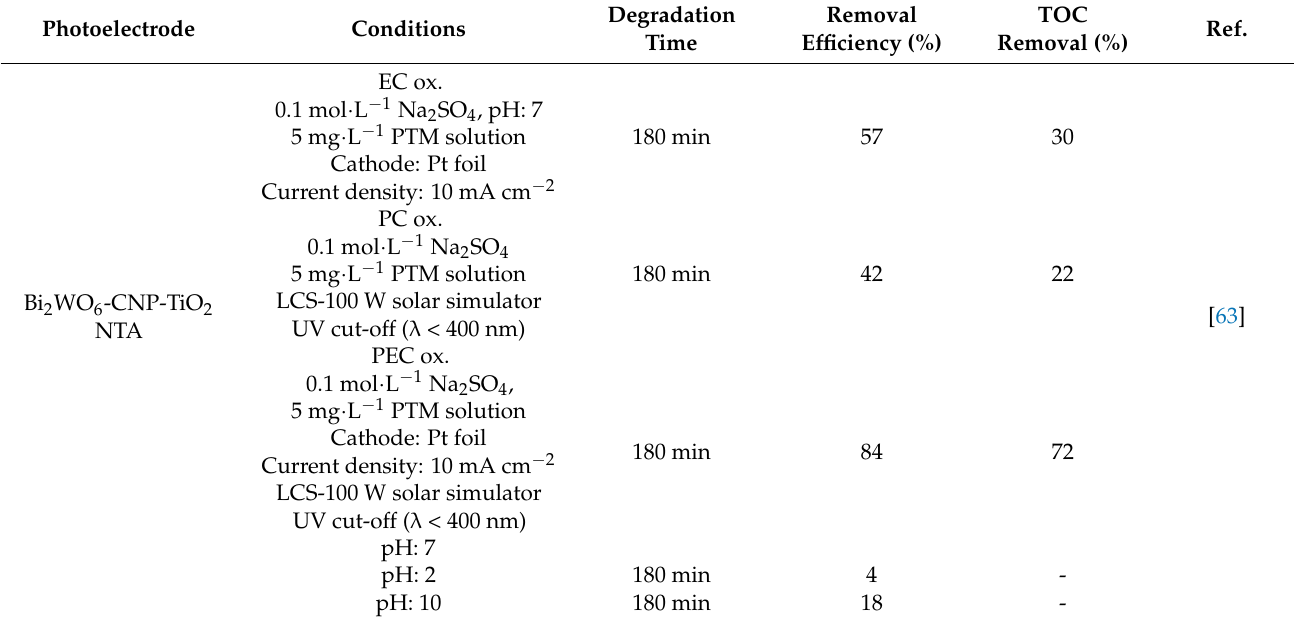
Table 3. PEC acetaminophen degradation using Bi 2 WO 6 -CNP-TiO 2 NTA-based photoelectrodes.